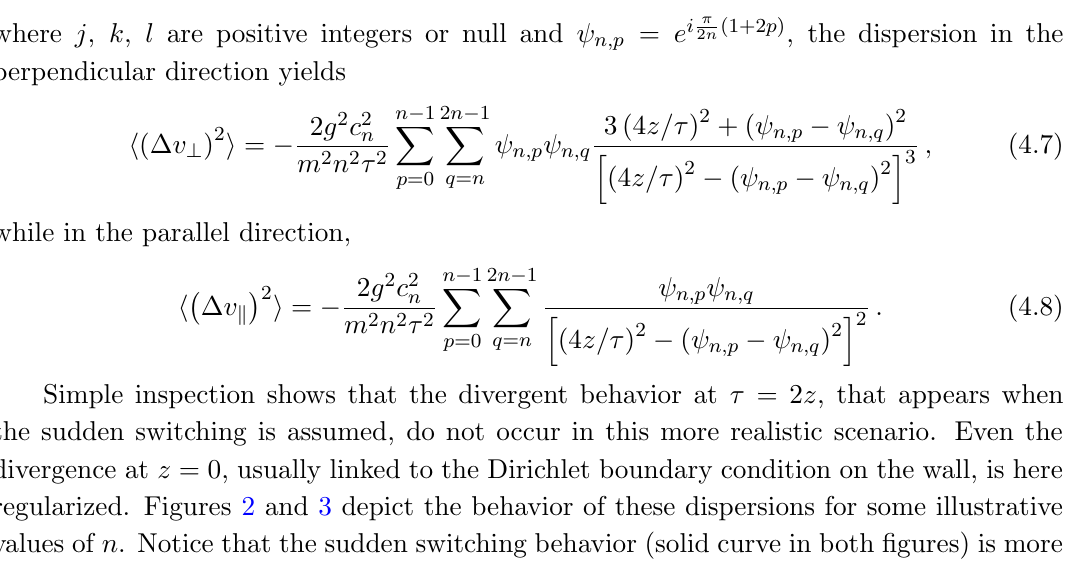
Figure 2 . Dispersion of the perpendicular component of the particle velocity as function of (cid:28) for the sudden switching regime (solid curve) and for some values of n in the case of a smooth